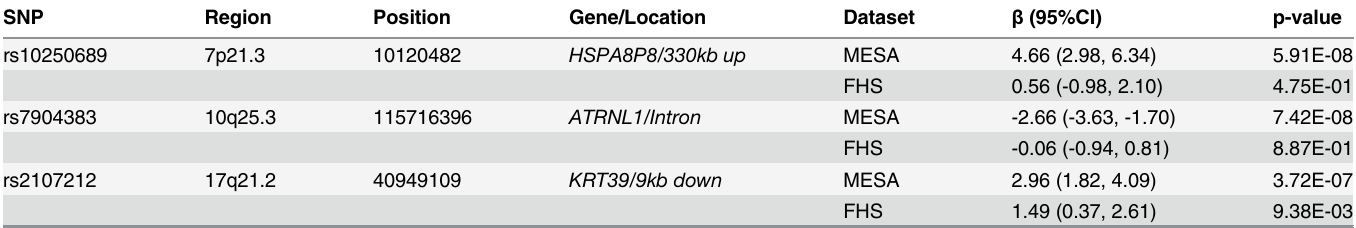
Table 2. Top interacting regions associated with BMI and replication in FHS. From the MESA gene by environment interaction analysis, regions with more than three genome-wide suggestive SNPs (interacting p-value < 5×10 − 7 ) in strong LD (r 2 > 0.8) were selected as top interacting regions. SNPs with fewer missing subjects in each region were chosen as tag SNPs to replicate in FHS. SNP position was based on the GRCh38